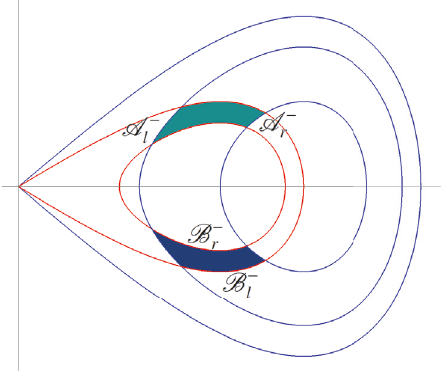
Figure 3: The present figure describes the oriented regions ̂ B (in lighterand darker colors, respectively). As in Figure 2 we have considered 𝑓(𝑥) = 𝑥 3 and 𝑉 1 = 2 , 𝑉 2 =